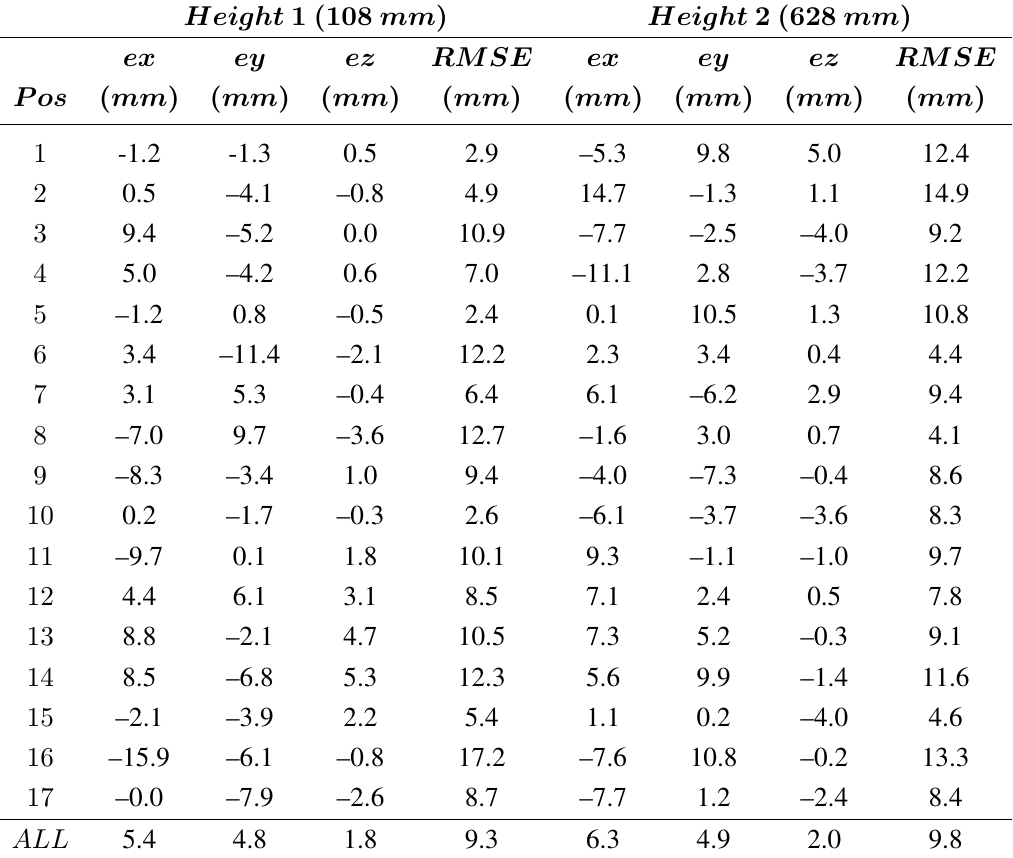
Table 4. The average location error of the measurements taken at each position. The ex, ey and ez values are respectively the errors in the x-axis, y-axis and z-axis obtained by subtracting the estimated coordinates of the node with the true coordinates for each position. The global location error is calculated from these errors as the root mean square error (RMSE) for the measurements taken at each position. The last row in the table shows the average absolute error from all measurements taken at the different positions for each